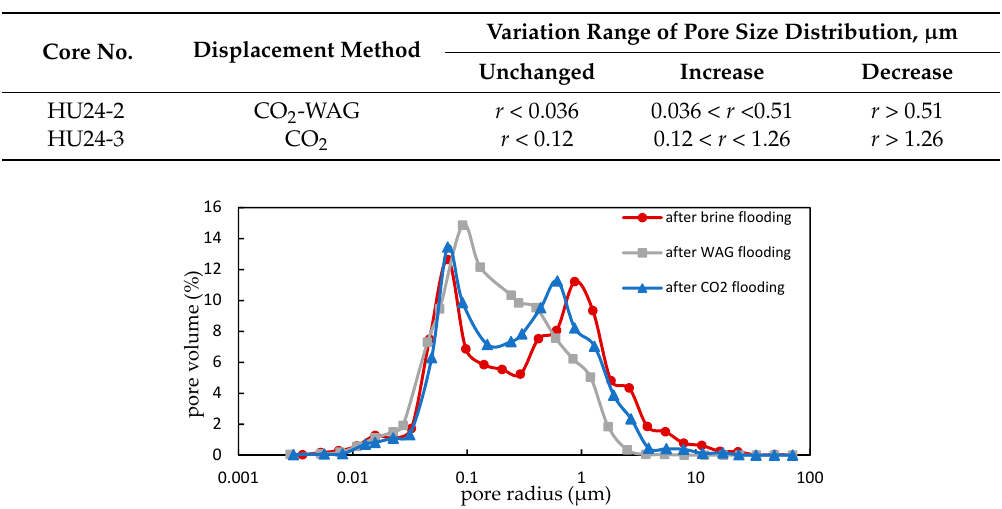
Figure 9. Pore size distribution obtained by the results of mercury injection measured on the three cores after flooding.